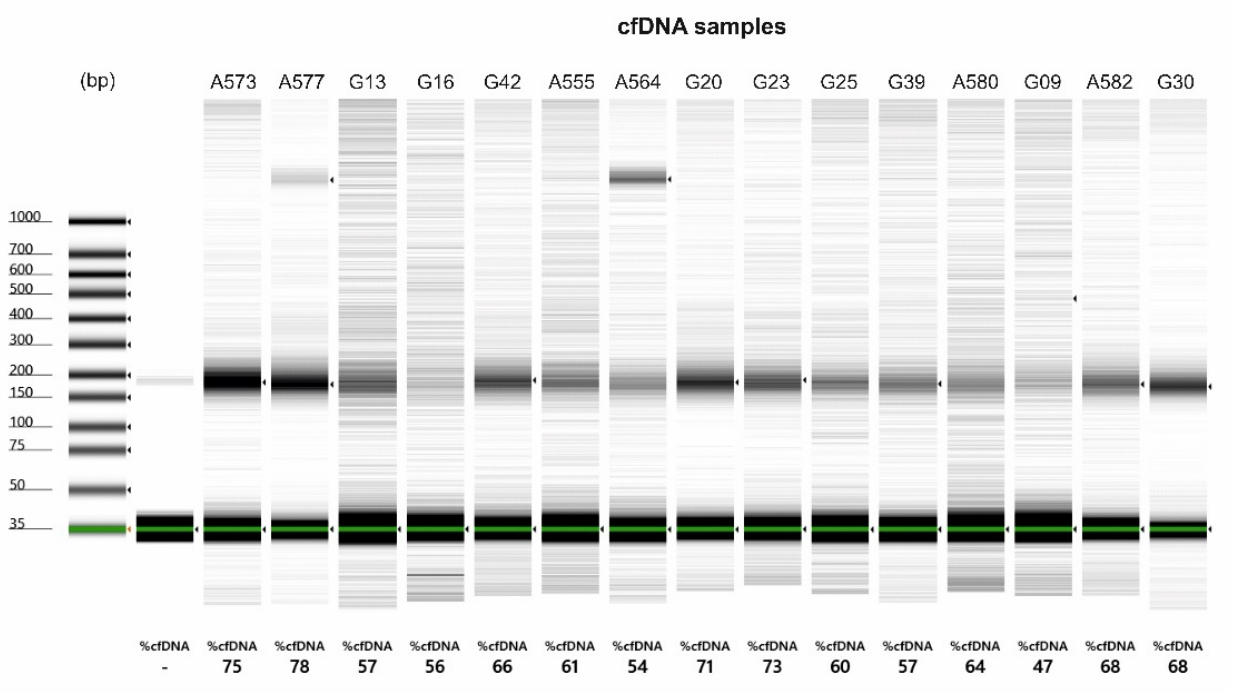
Figure A1. Quality assessment of cfDNA using Agilent Tape Station 2200 (Cell-free DNA screen tape assay).